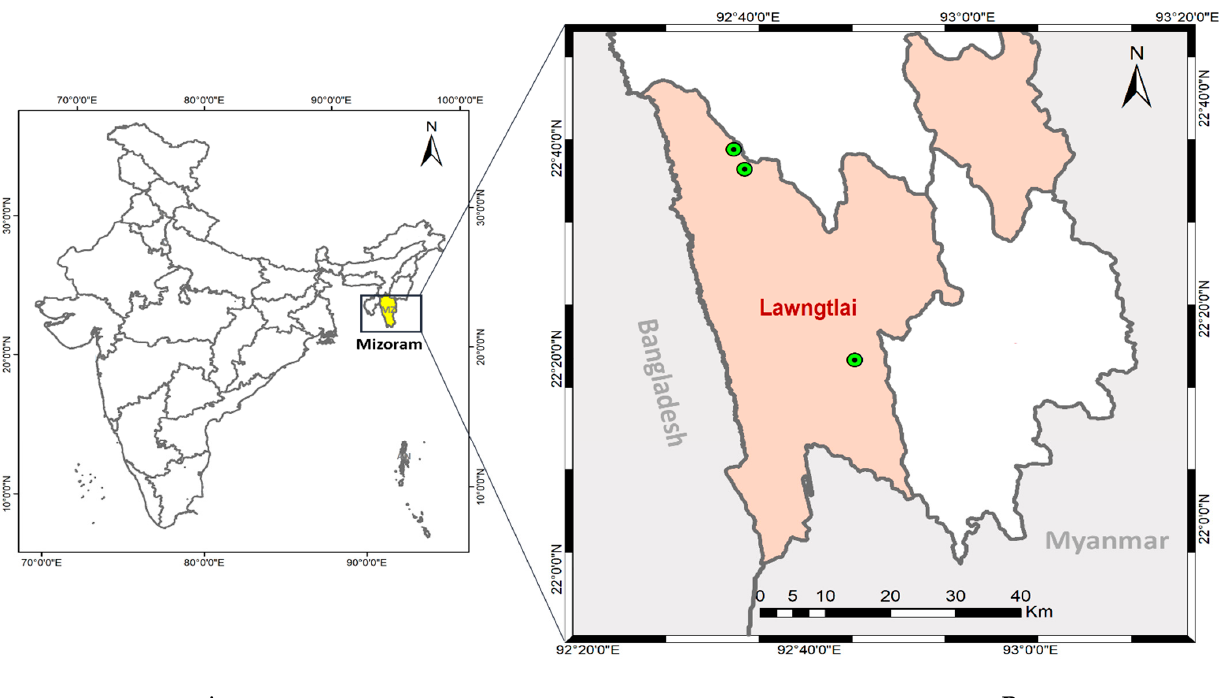
A B Figure 1. Map showing study sites ( A ) Mizoram, India; ( B ) the green circle shows the location of the P. malariae -positive cases detected in Lawngtlai District of Mizoram (India).